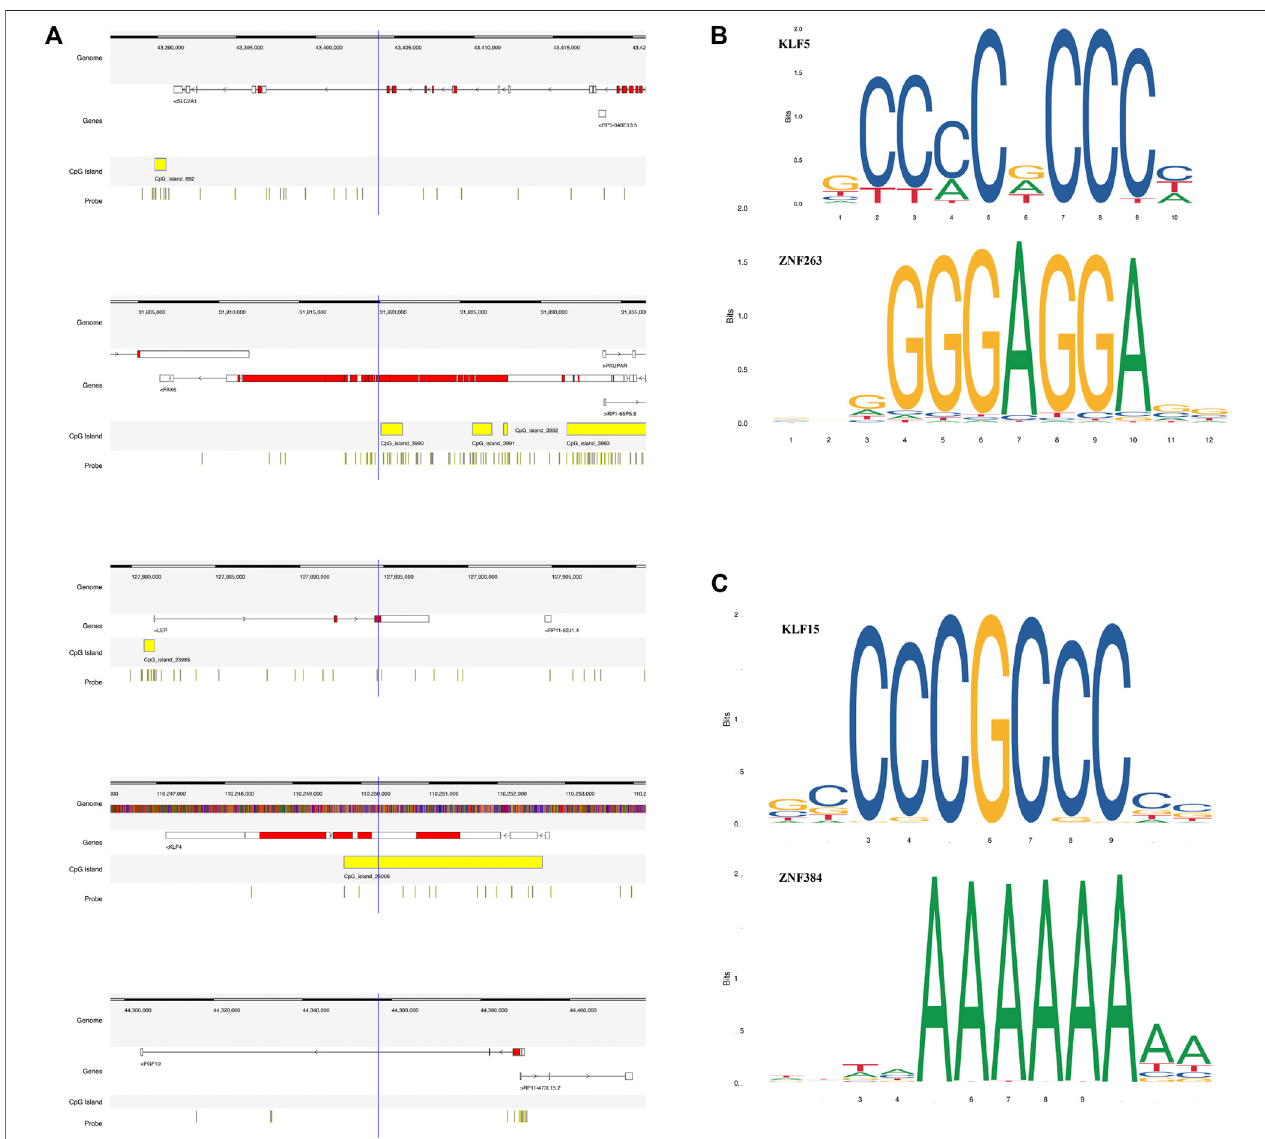
FIGURE8| Detailsofthe fi ve screened genes. (A) Epigenetic regulatory patterns ofboth miRNA and DNA methylation-regulatinggeneexpression,aswellasCpG island prediction analysis of fi ve screened genes. (B) The JASPER database predicted the sequence of two possible transcription factors of SLC2A1 . (C) The JASPER database predicted the sequence of two possible transcription factors of KLF4